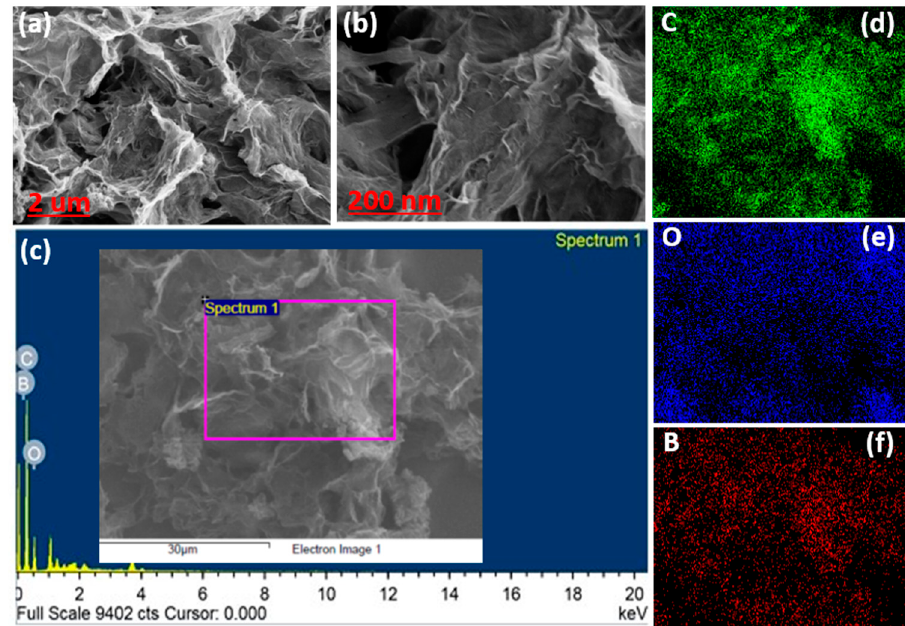
Figure 1. FESEM images of B-rGO at lower ( a ) and higher ( b ) magnifications. ( c ) EDX-spectra of B-rGO. The elemental mapping of ( d ) carbon, ( e ) oxygen, and ( f ) boron.